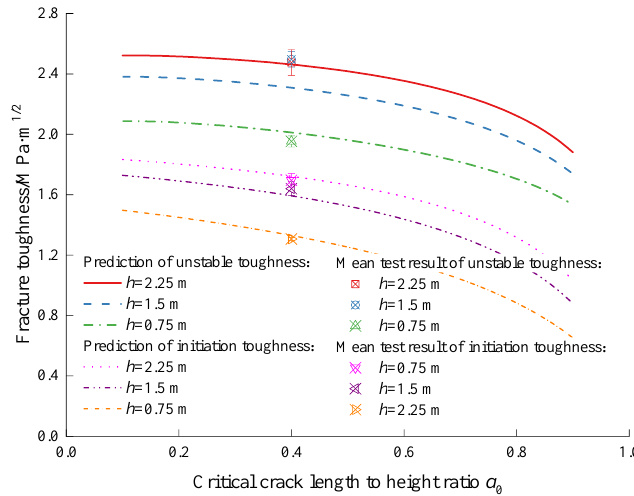
Figure 22. Fracture toughness of specimens with different α 0